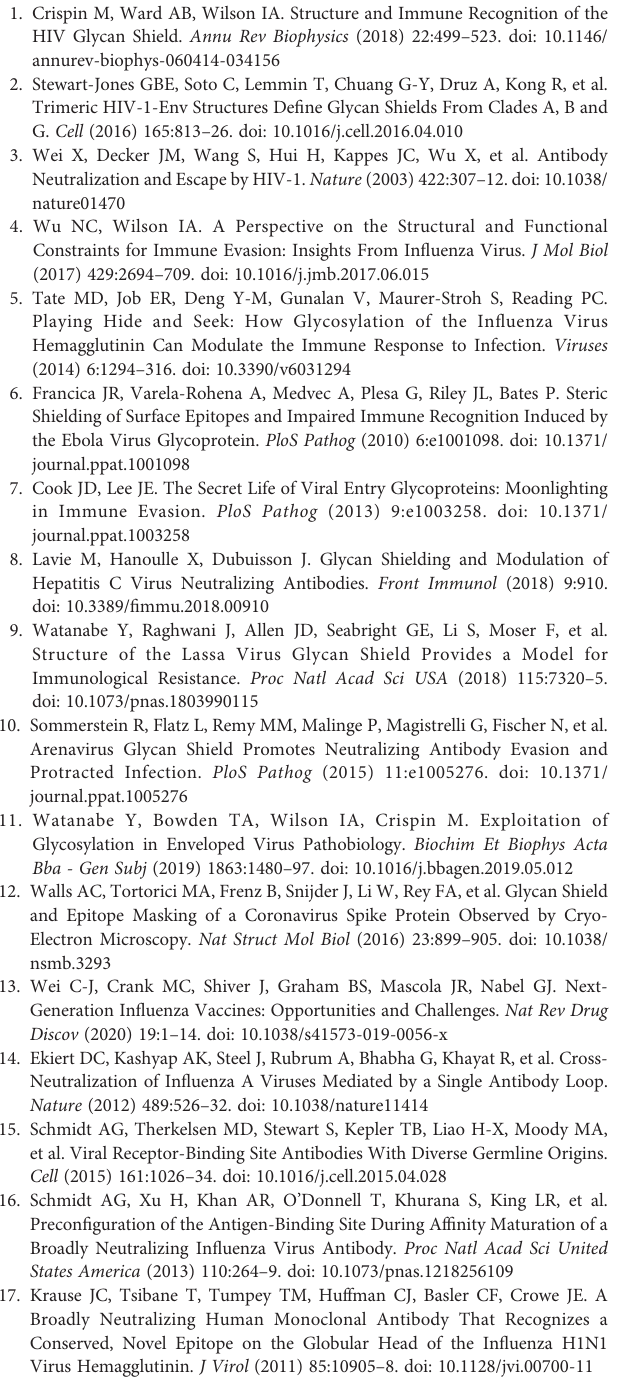
Supplementary Figure 3 | Time course of serum responses elicited by gHA immunogens - Plot titles indicate immunogen and x-axis indicates Luminex antigen. Supplementary Figure 4 | Day 28 serum elicited by gHA immunogens have limited breadth against a panel of antigenically distinct, historical H3 HAs. Day 0